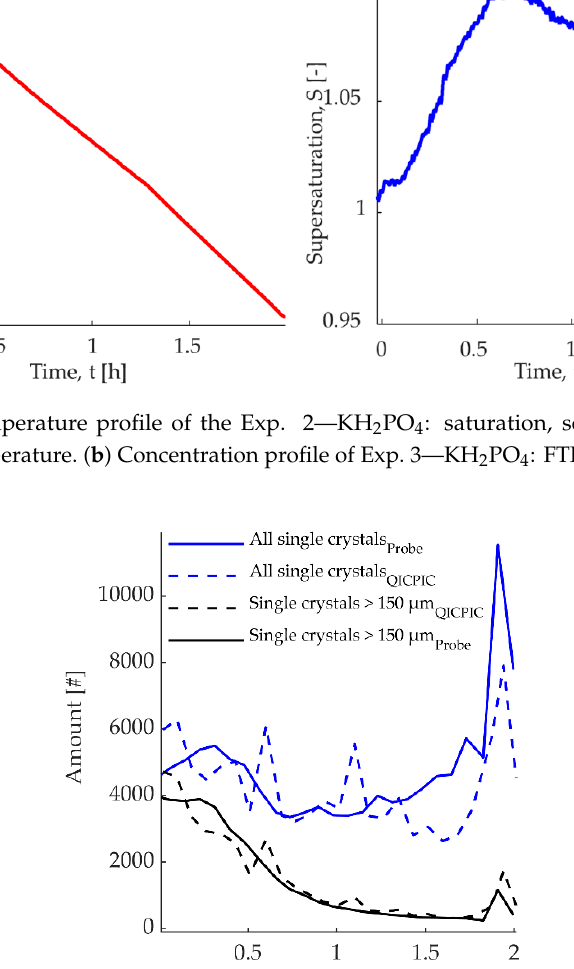
Figure A9. Quantity of single crystals analyzed during experiment Exp. 2 - KH 2 PO 4 .